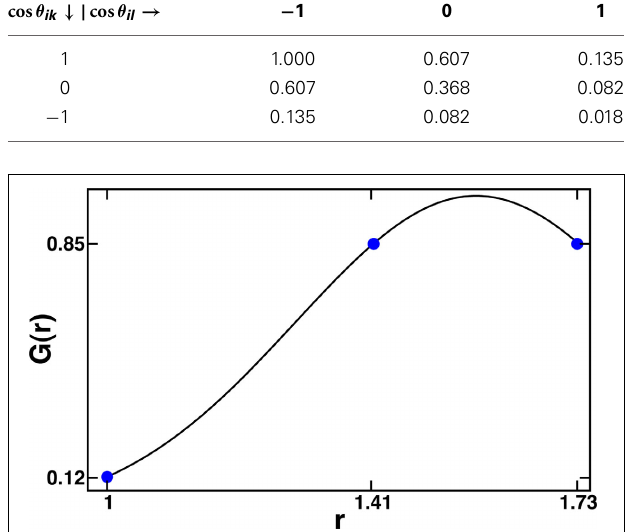
FIGURE 4 | Radial shape functions for the case σ R = 0 . 28 and √ √ 2 + 3) / 2. Note that nearest-neighbor interactions are roughly an R HB = ( order of magnitude weaker than next and next–next nearest neighbor ones. The blue points show the value of radial shape function for √ √ 2 and 3 corresponding to the nearest, the next–nearest and the r i = 1 , next–next nearest neighbors,